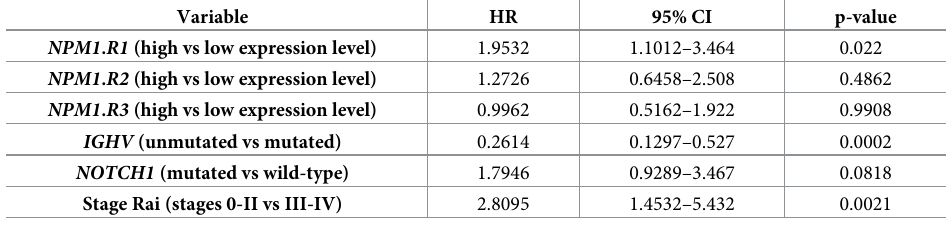
Table 2. Multivariate Cox analysis for NPM1 splice variants and the predictive CLL features (n =